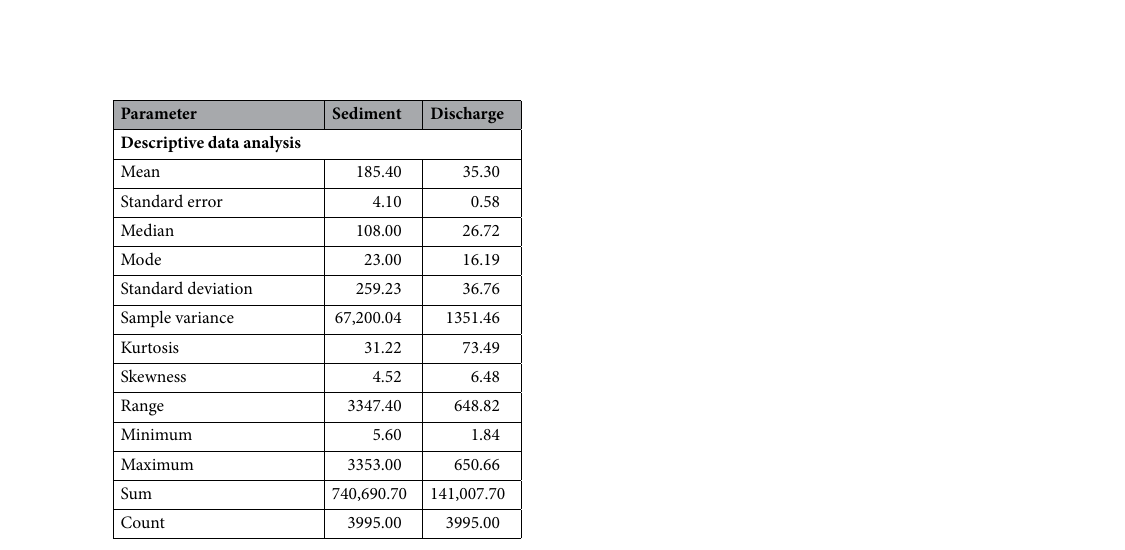
Table 1. Descriptive data analysis of sediment and discharge for the Johor River basin from 1988 to